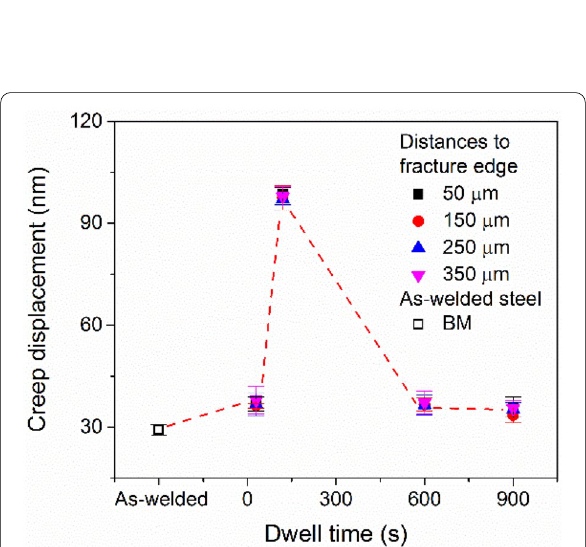
Figure 12 Comparison between creep displacement as function of dwells, which are measured in different distances to fracture edge CF-tested specimens as well as PWHT